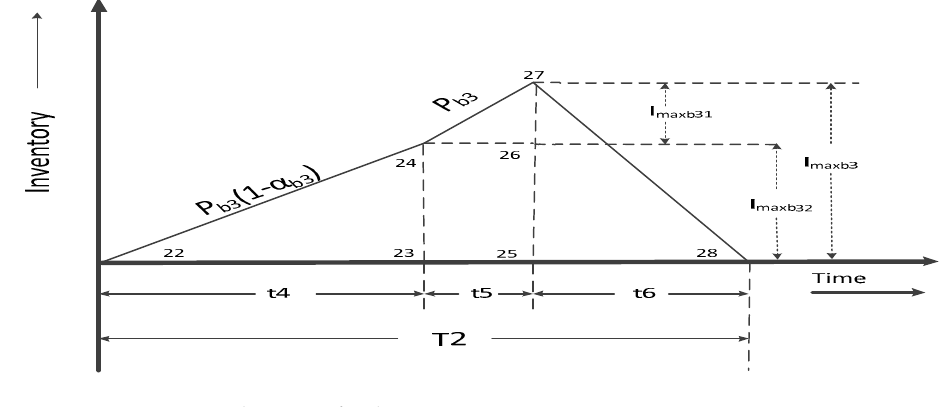
Figure A4. Inventory diagram of 3rd outsourcer .